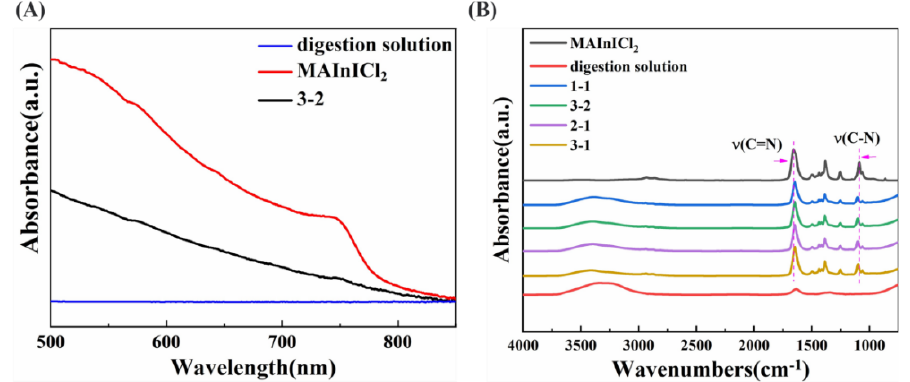
Figure 3. ( A ) UV−vis spectra of MAInICl 2 perovskite precursor solutions, digestion solution and mixtures (3−2). ( B ) IR spectra of MAInICl 2 perovskite precursor solutions, digestion solution and mixtures in different proportions.